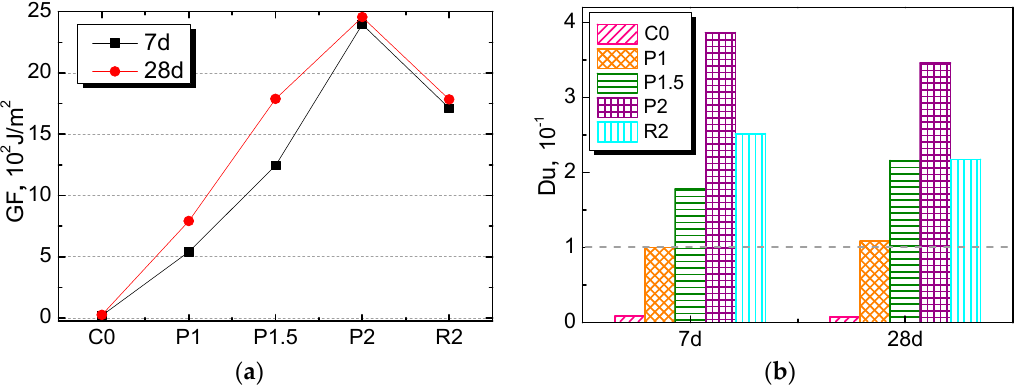
Figure 11. Fractural properties: (a) fracture energy and (b) ductility index of NPFRCCs at seven days and 28 days.